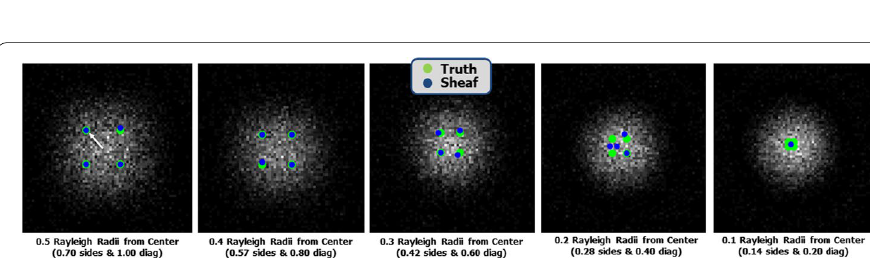
Fig. 4 Photon count distributions for four stars (green) at various inter-star separations, with the minimizers of consistency radius for the J 4 sheaf superimposed (blue) and ten thousand (10,000) total photons. (Star count known to be